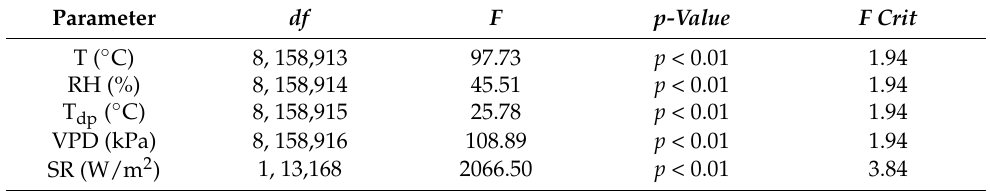
Table 8. ANOVA result of the T, RH, T dp , VPD, SR, and CO 2 distribution in DLG. T: air